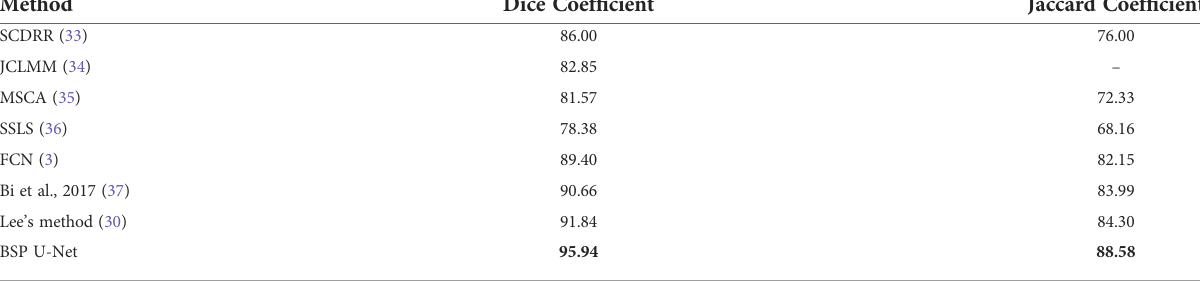
TABLE 2 Evaluation of U-Net, FCN, Lee ’ s network, and the proposed network on PH2 + ISBI 2016 challenge .